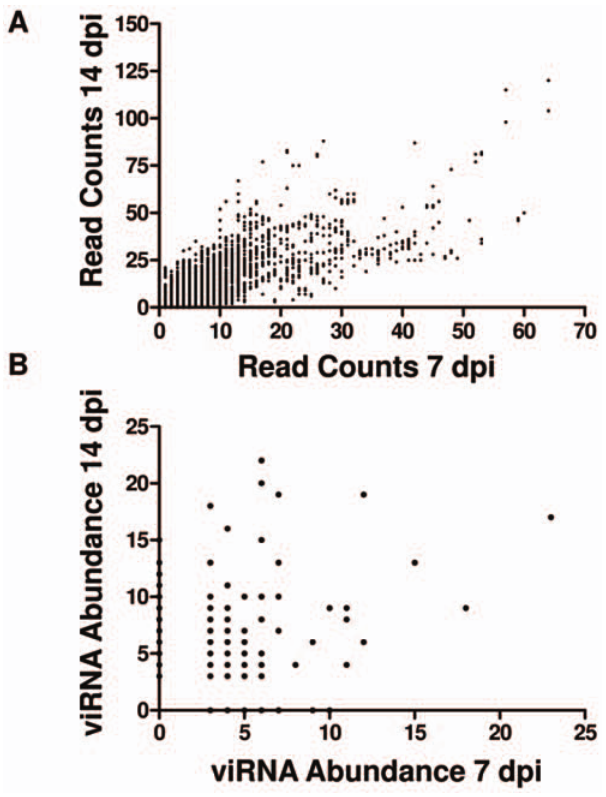
Figure 4. Targeting of the WNV Genome by RNAi at 7 and 14 Days Post Infection Is Correlated. (A) Count of reads aligning to each genome position at 7 and 14 days, n=11,029, Spearman r=0.7610, p , 0.0001. (B) Count of abundant individual sequence reads in libraries obtained at 7 and 14 days, n = 433, Pearson R- squared=0.03674, p , 0.0001.